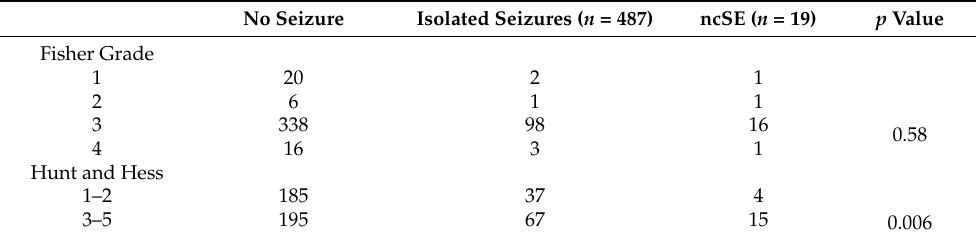
Table 4. Correlation between Fisher grading, Hunt and Hess classification and presence of seizure/ncSE.